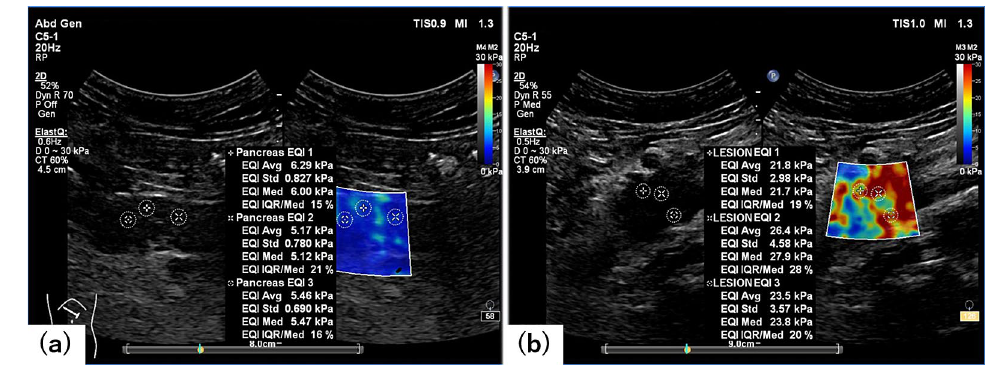
Figure 1. Shear wave elastography (SWE) images and measurements. ( a ) SWE images of normal pancreatic parenchyma. The left side image shows a B-mode image, and the right side image shows a stiffness map. Multiple regions of interest can be set anywhere in the stiffness map, and the SWE results are described in the center of the display. ( b ) SWE images of pancreatic